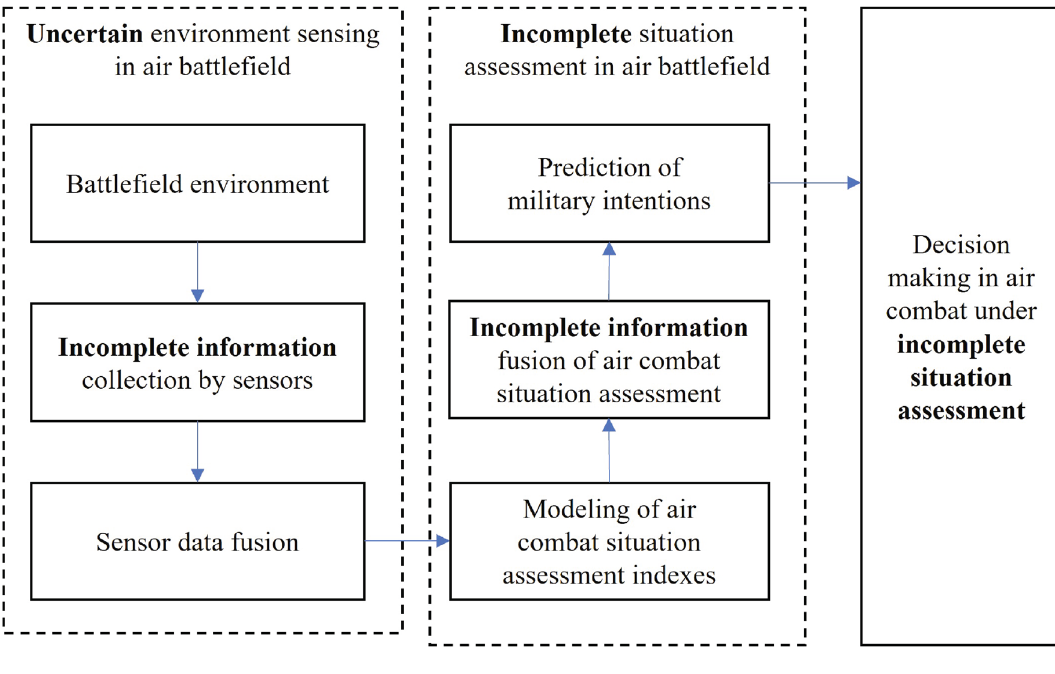
Figure 1. The framework of air combat situation assessment with incomplete situation in air battlefield.